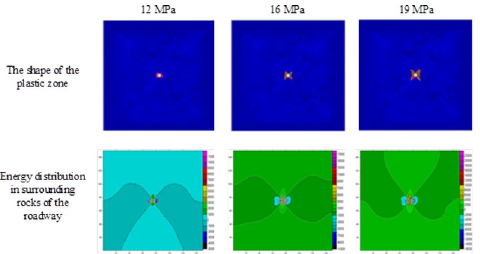
Fig 5. The shape of the plastic zone and the energy distribution of the surrounding rock of the roadway under the abutment pressure of 12–19